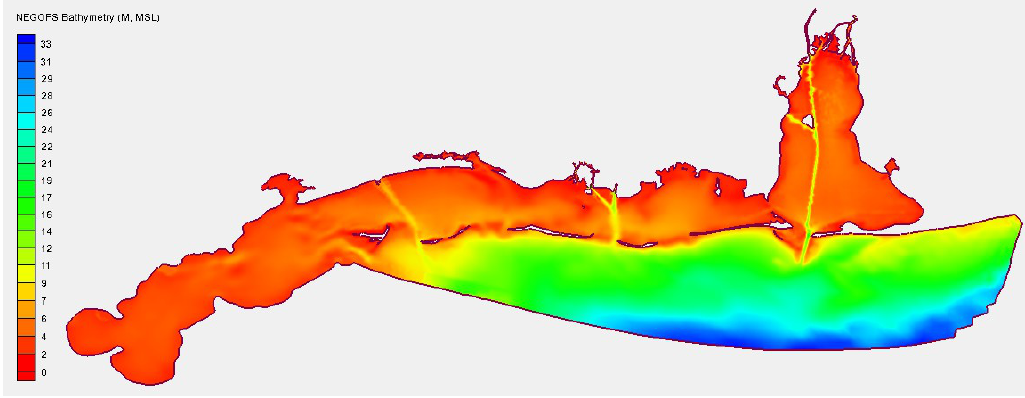
Figure 5. Northeast Gulf of Mexico Operational Forecast System (NEGOFS) bathymetry